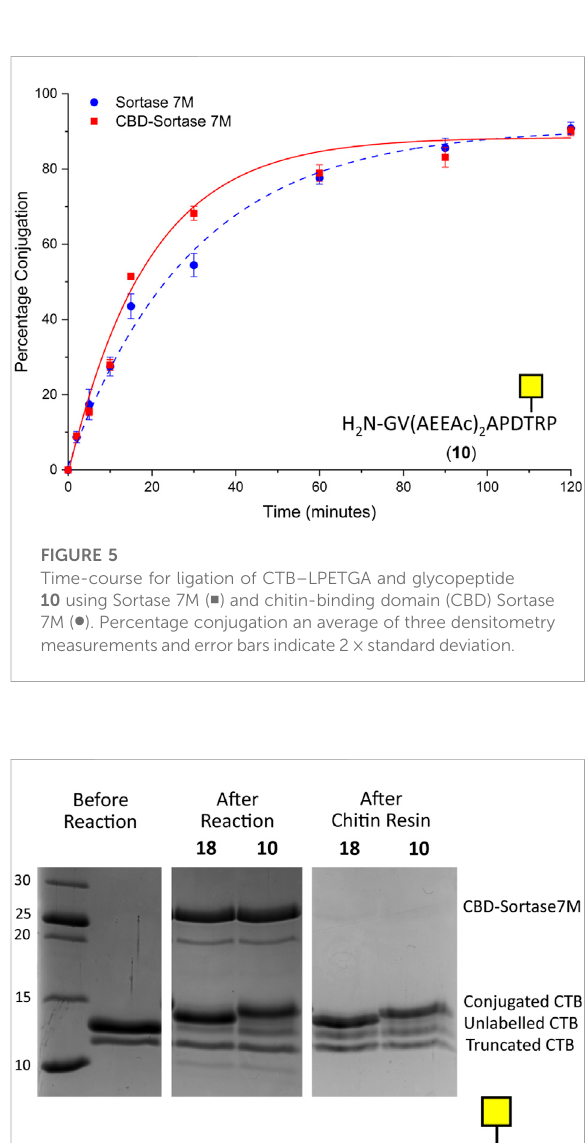
FIGURE 6 SDS-PAGE gel demonstrating removal of CBD-Sortase 7M fromreactionmixtureusing1.5 eqofchitinresin.Nochangeinthe level of conjugation is observed before and after removal of CBD- Sortase 7M.